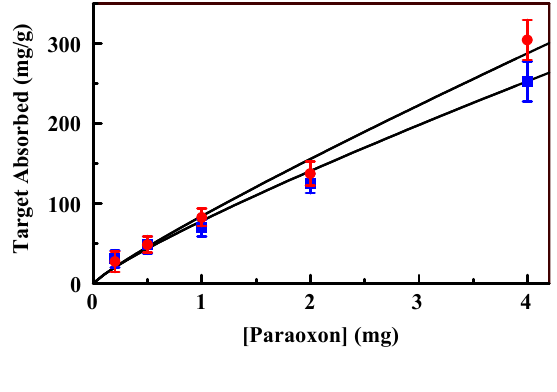
Figure 6. Paraoxon binding isotherms for imprinted (Material 2 , red) and non-imprinted (Material 1 , blue) organosilicate